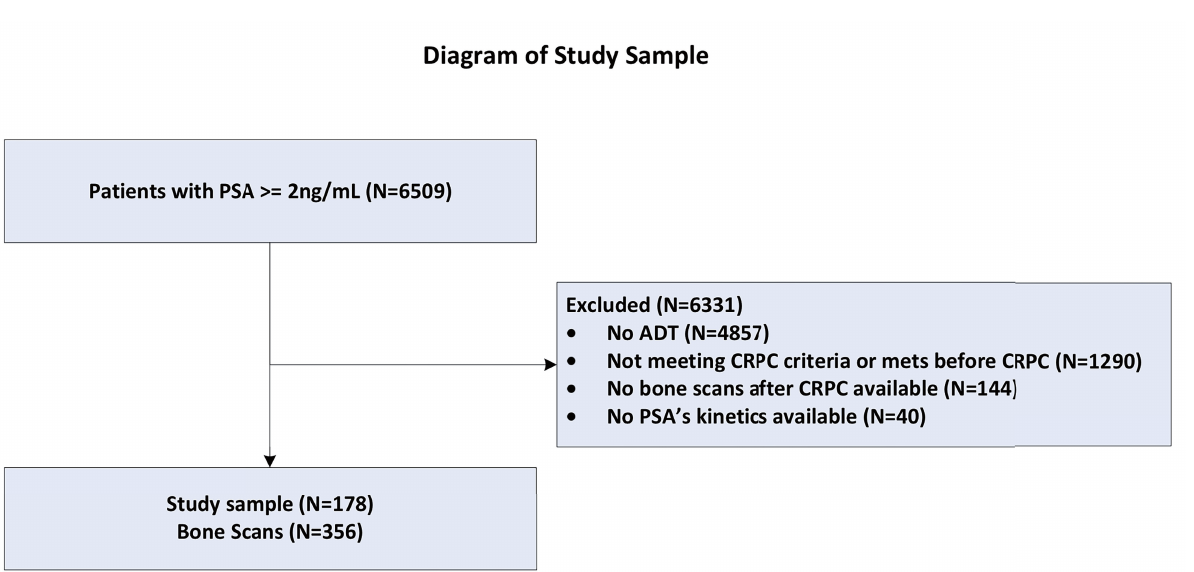
Figure 1 - CONSORT diagram of the study